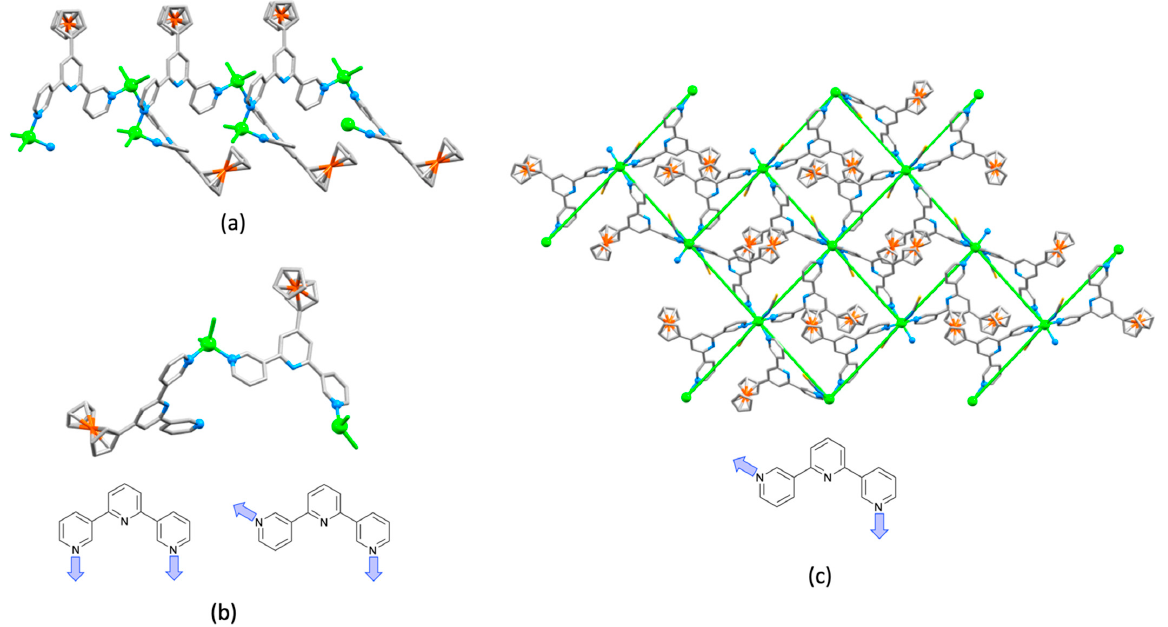
Figure 39. (a) Part of the 1D ‐ polymer in [Zn 2 Cl 4 ( 59 ) 2 ] n . 3 n H 2 O (CSD refcode VUKMOF) and (b) the asymmetric unit in [Zn 2 Cl 4 ( 59 ) 2 ] n . 3 n H 2 O and diagram showing the different conformations (in planar notation) of the crystallographically independent ligands 59 . (c) Part of the (4,4) net observed in [Zn 3 (NCS) 6 ( 59 ) 6 ] . 6 n CHCl 3 (refcode OGOYIU). Each Zn is a 4 ‐ connecting node and the Zn 4 rhombuses are highlighted; the conformation of the 3,2’:6’,3’’ ‐ tpy units is shown in planar notation.